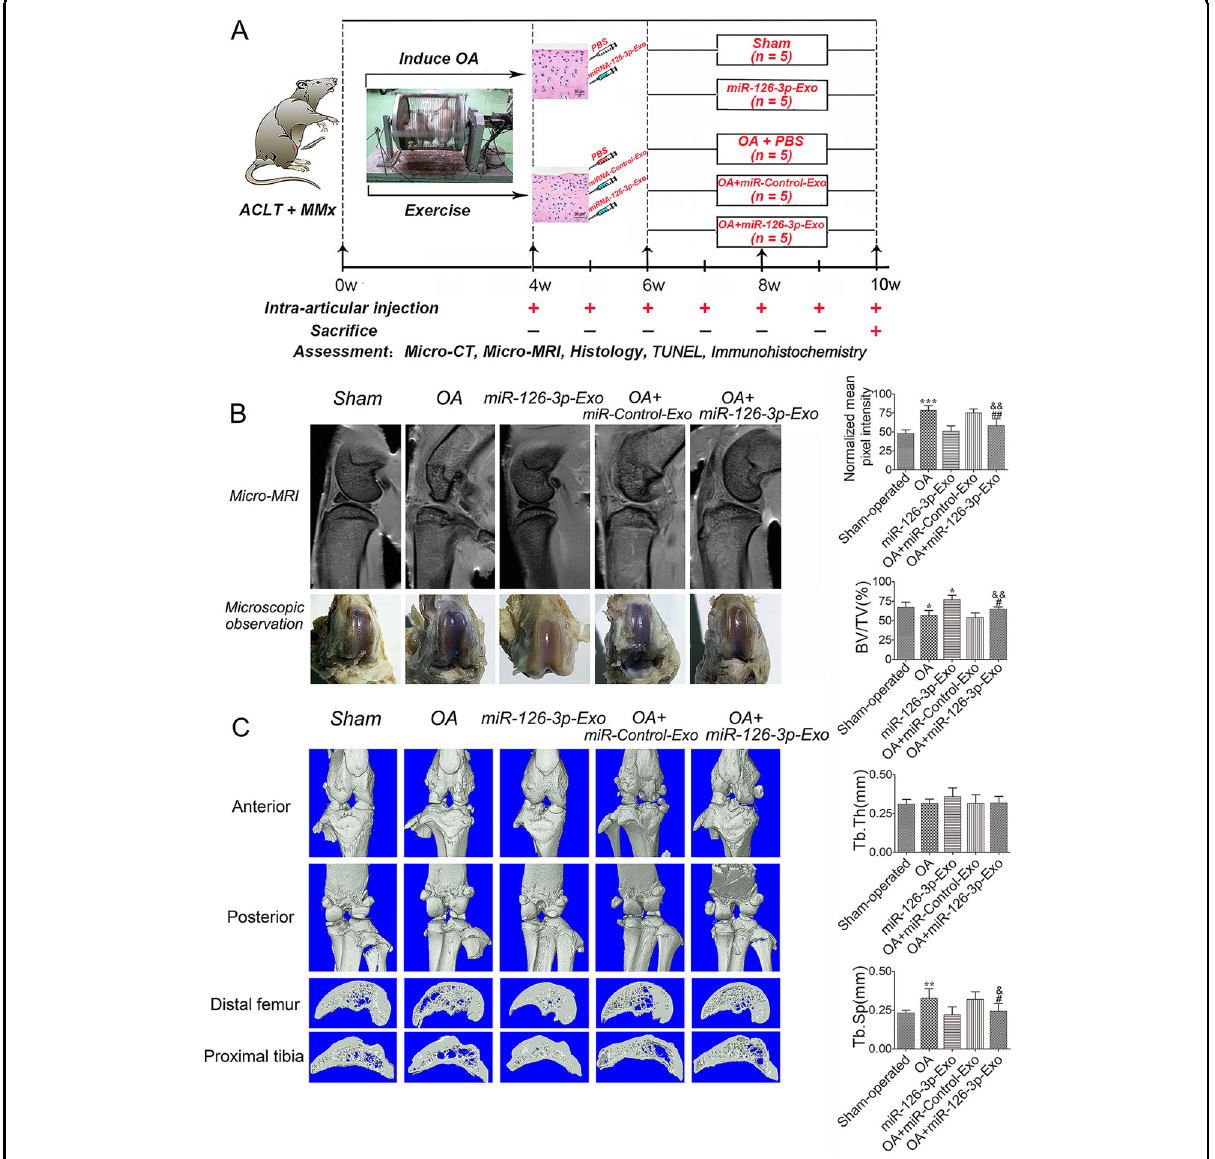
Fig. 4 An overview of study timelines and the rescue of cartilage degeneration by SFC-miR-126-3p-Exos in OA model rats. A ACLT + MMx rats were put into an electronic rotator cage for 30min per day as a means of inducing the OA model beginning 1-week post-surgery. At 4 weeks post- surgery, animals were intra-articularly injected with 40 μ l of 500 μ g/ml SFC-miR-126-3p-Exos. PBS was used as a control in sham and OA-model animals. At 10 weeks post-surgery, the micro-MRI, micro-CT, histology, TUNEL assay, and immunohistochemistry were used as evaluation criteria. B Pixel intensity of a sampled region of epiphyseal trabecular bone and gross morphological were assessed by micro-MRI to quantify the presence of bone marrow lesions in sham operation, SFC-miRNA-126-3p-Exos, OA-induction, OA + SFC-control-Exos, and OA + SFC-miRNA-126-3p-Exos, groups. C Representative micro-CT three-dimensional reconstructions of tibial and femoral subchondral bones in the rats after ACLT + MMx surgery. Micro-CT images of animals in each group were used for measurements of BV/TV, Tb. Th and Tb. Sp. Data were expressed as mean±SEM ( n = 5). * P <0.05, ** P <0.01, and *** P <0.001 vs. sham-operated group; # P <0.05 and ## P <0.01 vs. OA induction group; & P <0.05 and && P <0.01 vs. OA + miR-Control-Exos